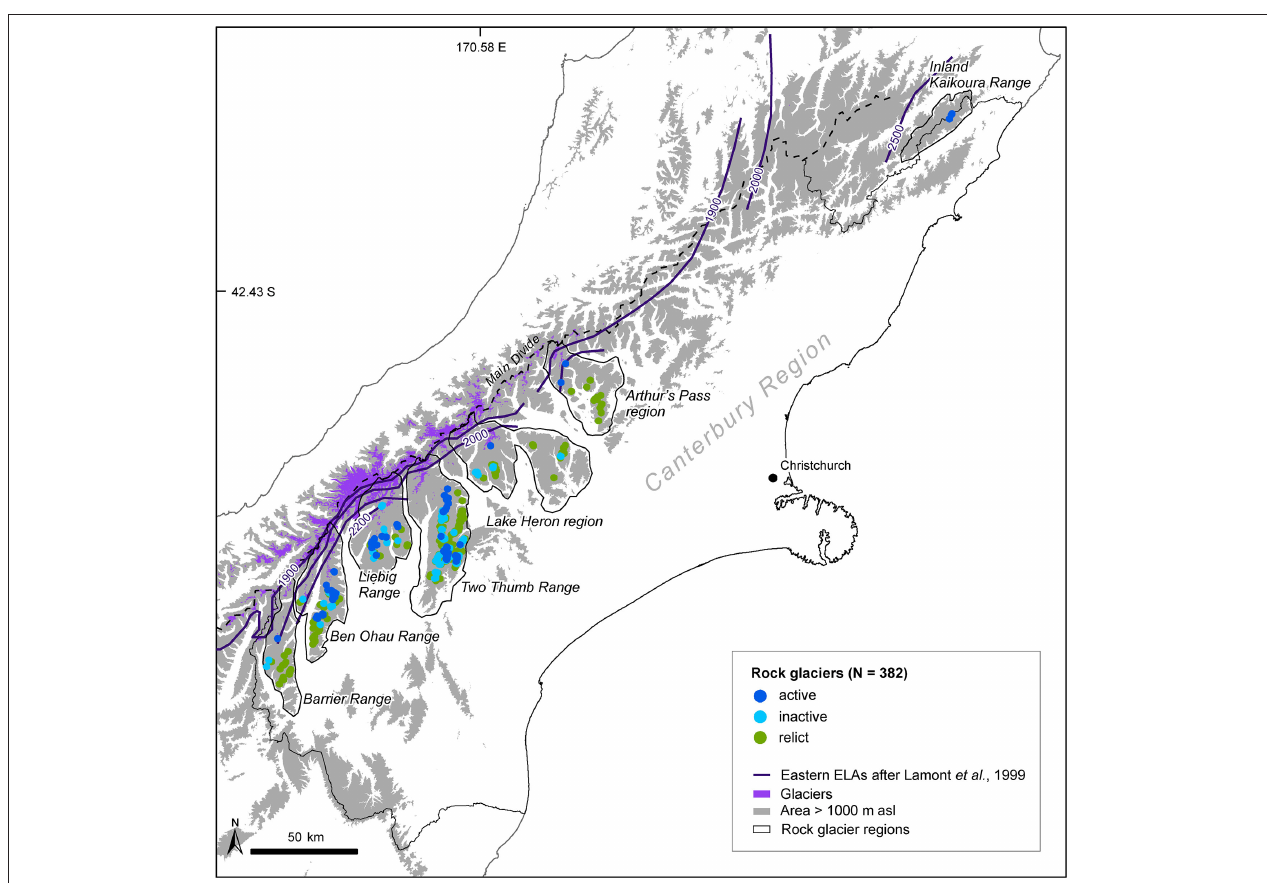
FIGURE 4 | Rock glacier inventory for the Canterbury Region, separated into seven topographic regions. The western (and equally upper altitudinal) boundary of rock glacier occurrence in the Canterbury Southern Alps corresponds well with Lamont et al.’s (1999) equilibrium line altitude (ELA) estimates of 2000–2200m for the eastern ranges. Glacier extent: Randolph Glacier Inventory 5.0 ( GLIMS/NSDIR, 2015), elevation data: 25m DEM, Barringer et al. (2002), coastline and regional boundaries: Statistics New Zealand